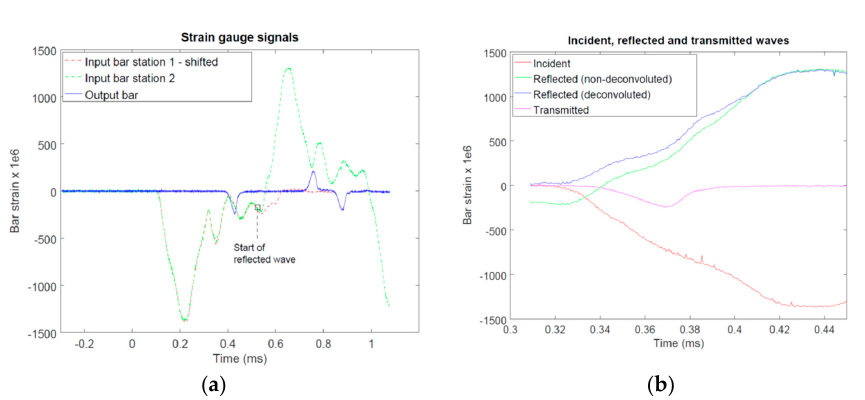
Figure 5. Example of the strain gauge signals recorded during the SHPB tests: ( a ) signals from the strain gauge stations and ( b ) incident, reflected (with and without deconvolution) and transmitted waves after time-shifting to specimen interface location (zoom-in on the early portion of the waves). In Equation (2) E bar and A bar denote the Young’s modulus and cross-sectional area of the bar, respectively. The transmitted wave strain amplitude (time-shifted to specimen/output bar interface) is denoted by ε trans . The accuracy of the measurements and the deconvolution was determined to be sufficient for the calculation of the bar end velocities ( v input and v output ) (Equations (3) and (4)): (cid:4666)𝑡(cid:4667) = −𝑐 (cid:4666)𝑡(cid:4667) − 𝜀 (cid:4666)𝑡(cid:4667)(cid:4673) 𝑣 (cid:4672)𝜀 (cid:3036)(cid:3041)(cid:3043)(cid:3048)(cid:3047) (cid:3029)(cid:3028)(cid:3045) (cid:3036)(cid:3041)(cid:3030)(cid:3036) (cid:3045)(cid:3032)(cid:3033)